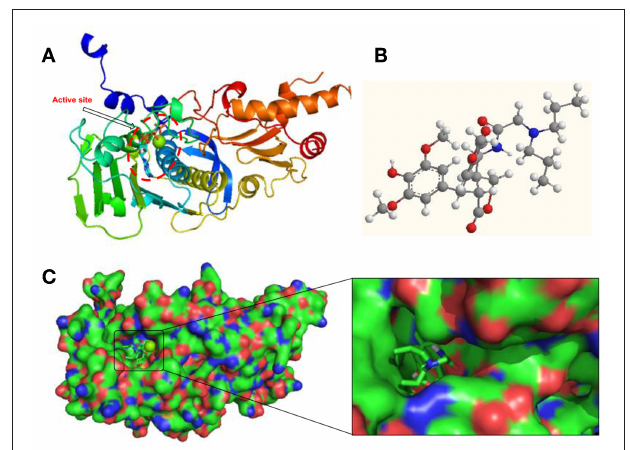
FIGURE 5 | Human DNA topoisomerase II α active site in complex with its ligand AMP-PNP or synthesized compound 12g . (A) X-ray crystal structure of human DNA topoisomerase II α active site in complex with AMP-PNP. (B) The 3D chemical structure of compound 12g . (C) The surface structure of human DNA topoisomerase II α binding pocket in complex with 12g